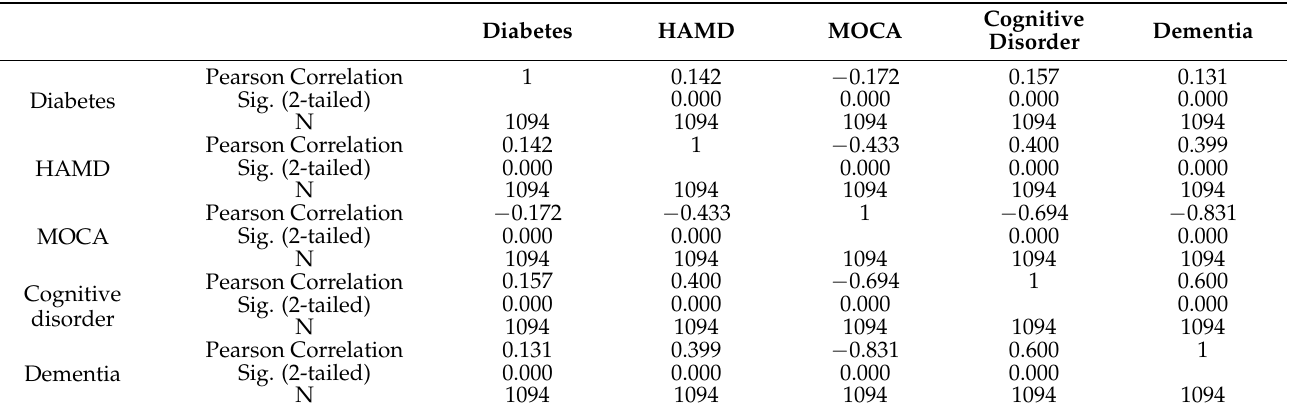
Table 8. Pearson correlation